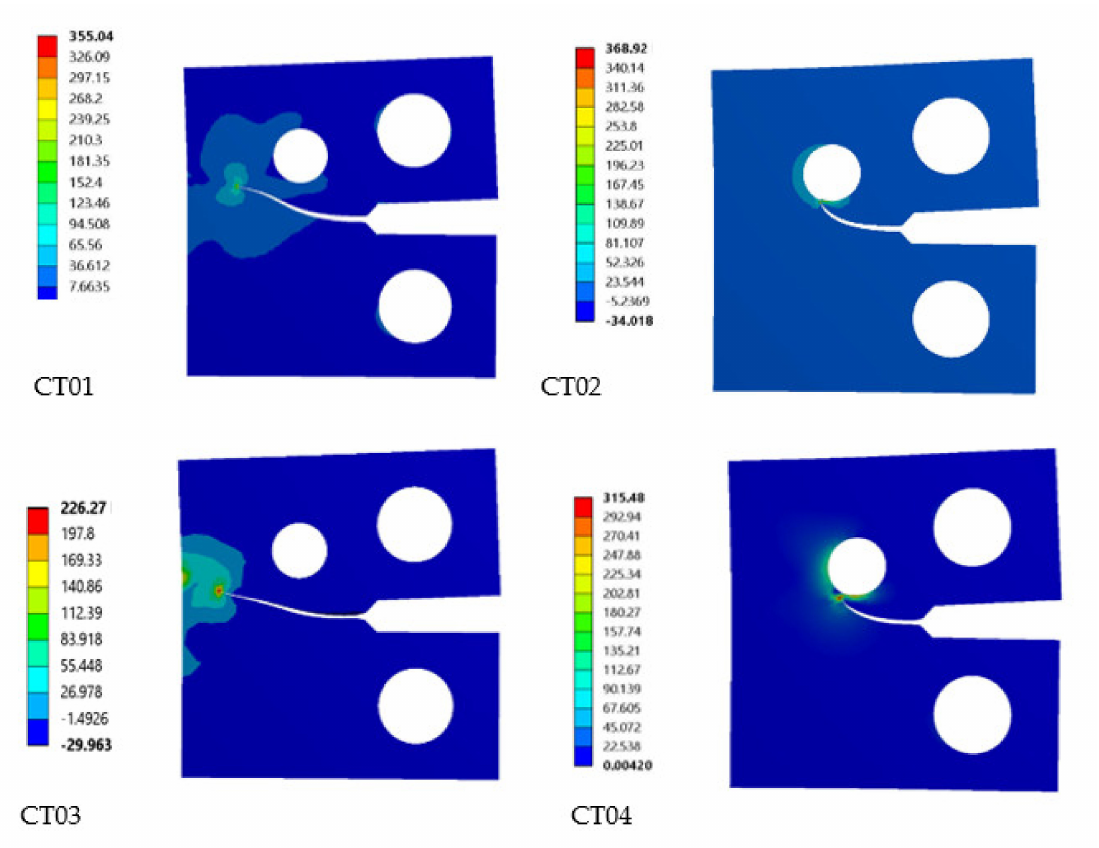
Figure 10. Maximum principal stress distribution for di ff erent configuration of